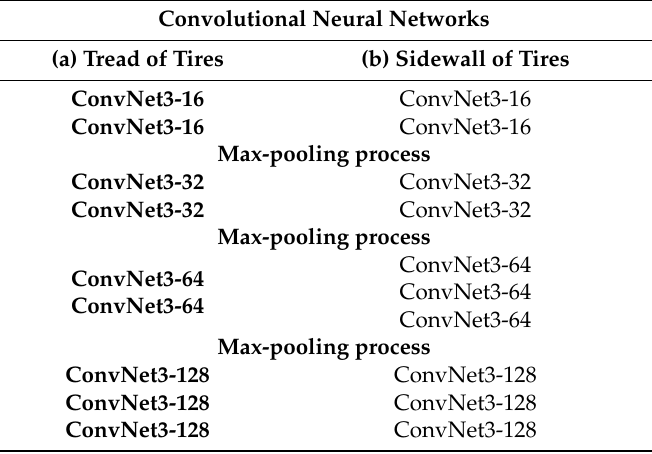
Figure 6. ( a ) The proposed hybrid Faster Region-Based ConvNets architecture for diagnosing the bubble-defects in treads and ( b ) The proposed hybrid Faster Region-Based ConvNets architecture for diagnosing the bubble-defects in sidewalls of tires. Table 1. The various components of the proposed hybrid model.